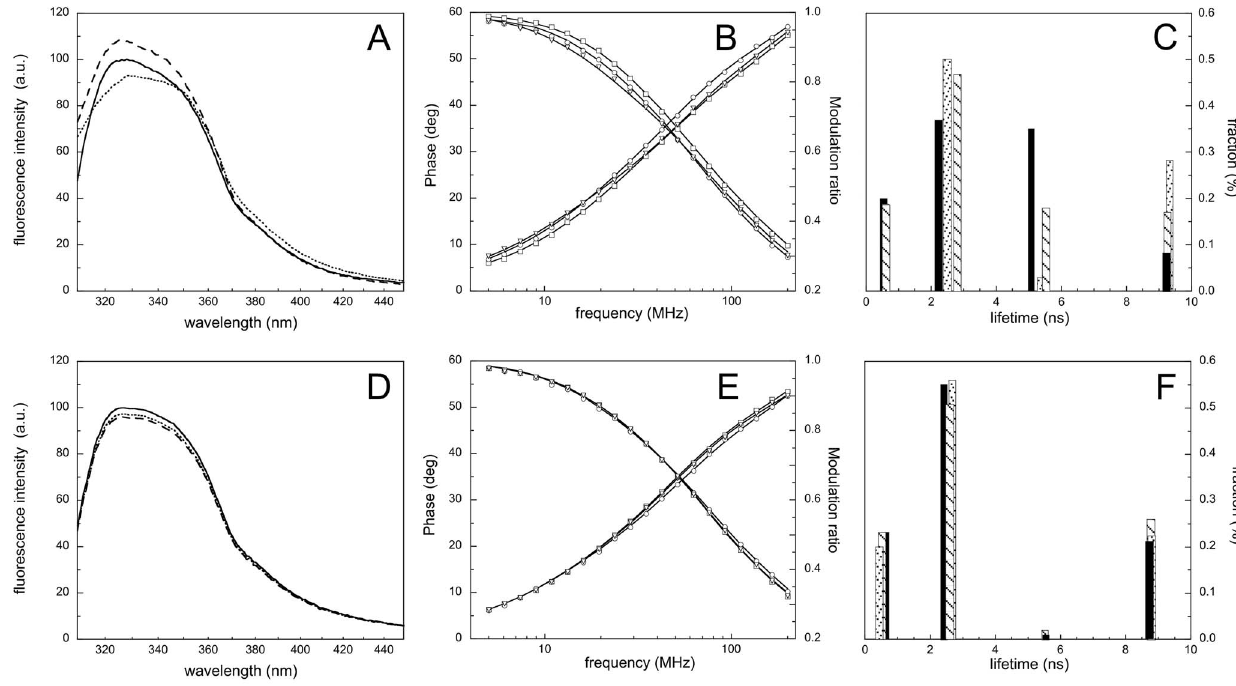
Figure 4. Fluorescence properties of rArom and the mutant Trp224Phe. A) Steady-state fluorescence emission spectra ( l exc =293 nm) of rArom in the absence (solid line) and in the presence of the substrate androstenedione (dashed line) or the inhibitor anastrozole (dotted line). B) Phase-shift and demodulation data of rArom in the absence (squares), and in the presence of the substrate androstenedione (circles) or the inhibitor anastrozole (triangles). C) Fluorescence lifetimes obtained from the fitting of the experimental data to a four discrete components model for rArom in the absence (black bars), and in the presence of the substrate androstenedione (dashed bars) or the inhibitor anastrozole (dotted bars). Panels D), E) and F) use the same symbols to show the results obtained under the same conditions for mutant